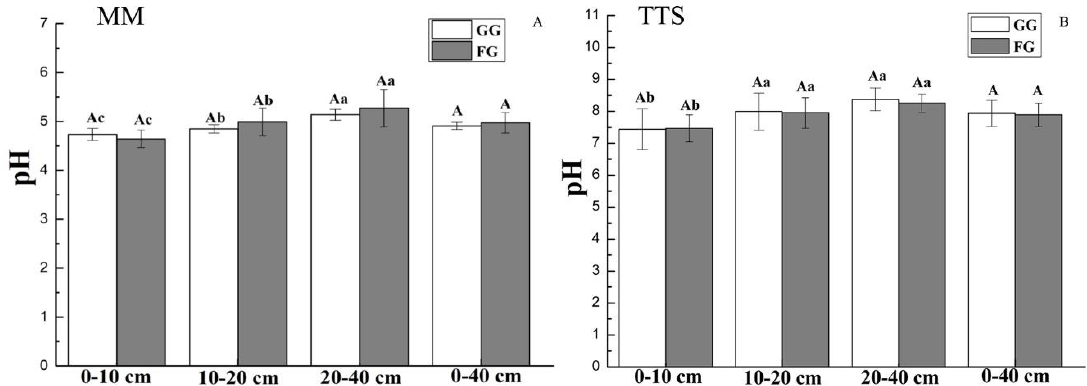
Figure 3. ( A ): Soil pH in the MM under the grazing and fencing treatments; ( B ): Soil pH in the TTS under the grazing and fencing treatments. Values are the means ± standard deviation, the bar charts marked with di ff erent letters on the top of the column (Di ff erent lowercase letters for di ff erent soil layers, and di ff erent capital letters for di ff erent treatments) are significantly di ff erent ( p < 0.05). MM: mountain meadow; TTS: temperate typical steppe; GG: grazed grassland; FG: fenced grassland.